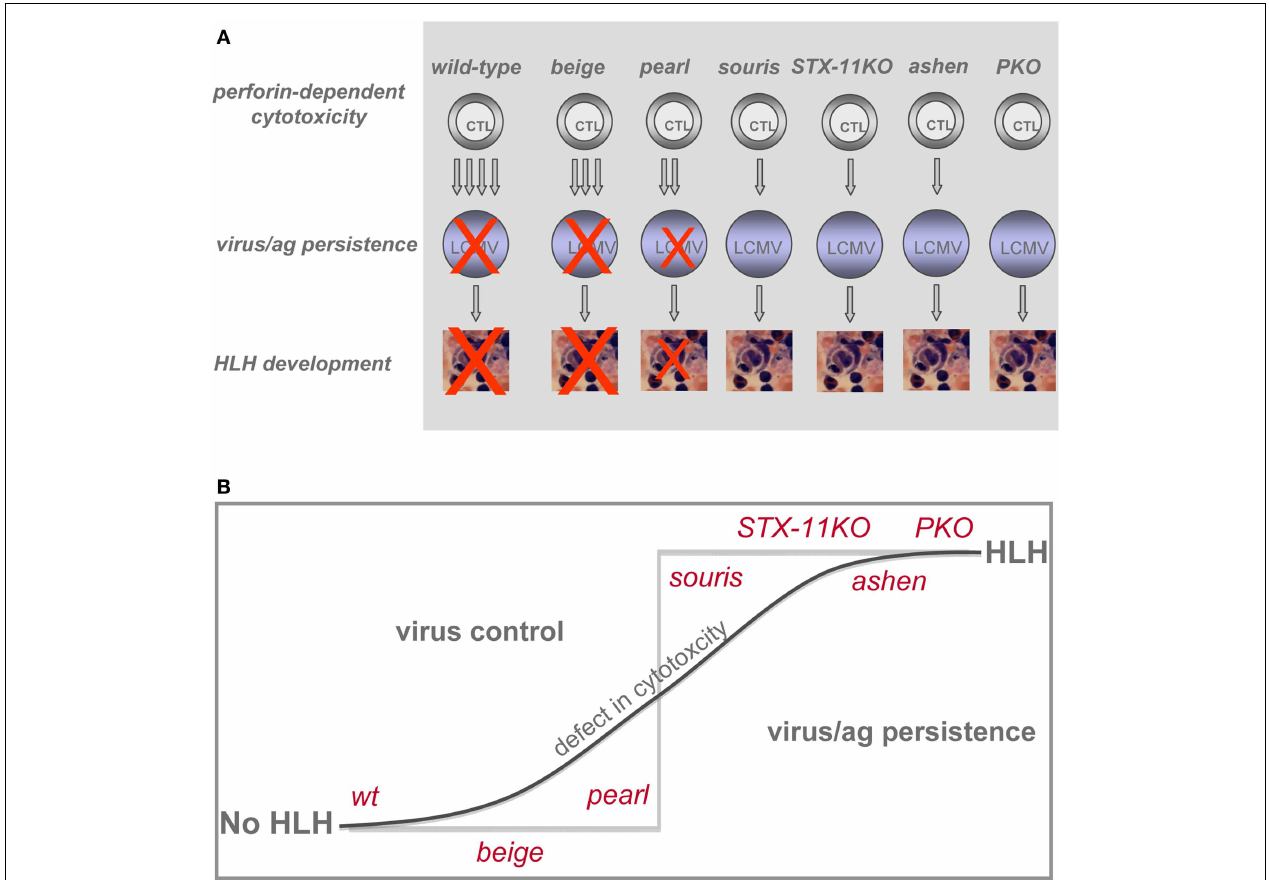
FIGURE 6 | Impact of various genetic defects on threshold of HLH development . (A) Differences in CTL cytotoxicity and their impact on LCMV control determine whether or not HLH develops. (B) Pronounced impairment of CTL cytotoxicity results in loss of virus control and development of